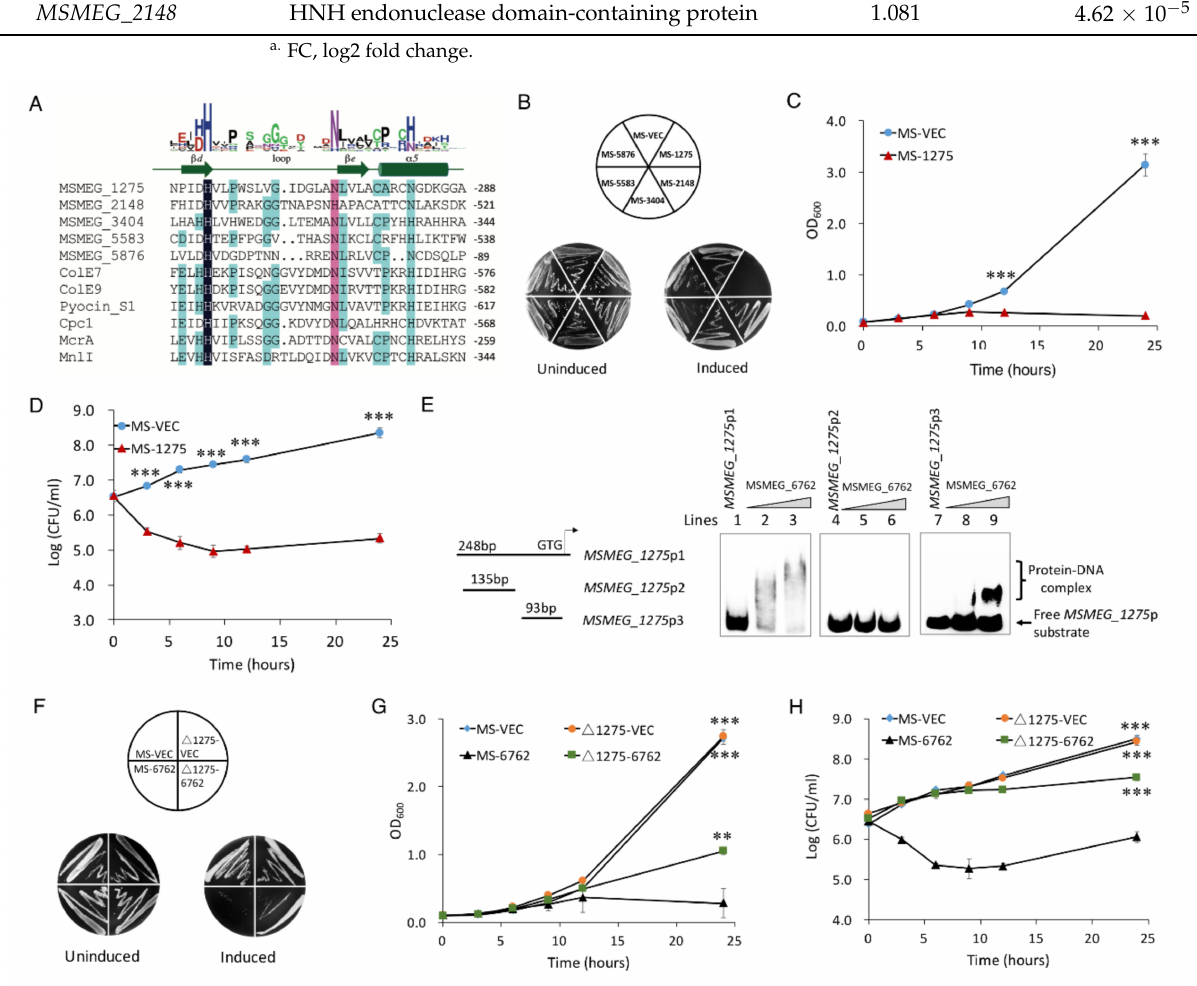
Figure 4. MSMEG_6762 causes cell death by an unregulated HNH nuclease MSMEG_1275. ( A ) Se- quence alignment of HNH proteins. ( B ) Overexpression of HNH domain genes on 7H10 plates. ( C ) The effect of MSMEG_1275 on the cell growth of MS-1275. ( D ) The bactericidal activity of HNH nuclease MSMEG_1275 on cell viability of MS-1275. Log-phase cultures were streaked on 50 µ g/mL hygromycin 7H10 plates with or without 1% acetamide. Significance of MS-VEC strain compared to MS-1275 strain was determined using a Student’s t test: *** p < 0.001. ( E ) EMSA assays for the binding of MSMEG_6762 to MSMEG_1275 promoter DNA fragments. The MSMEG_1275 promoter DNA substrates were co-incubated with gradually increasing concentrations of MSMEG_6762 protein